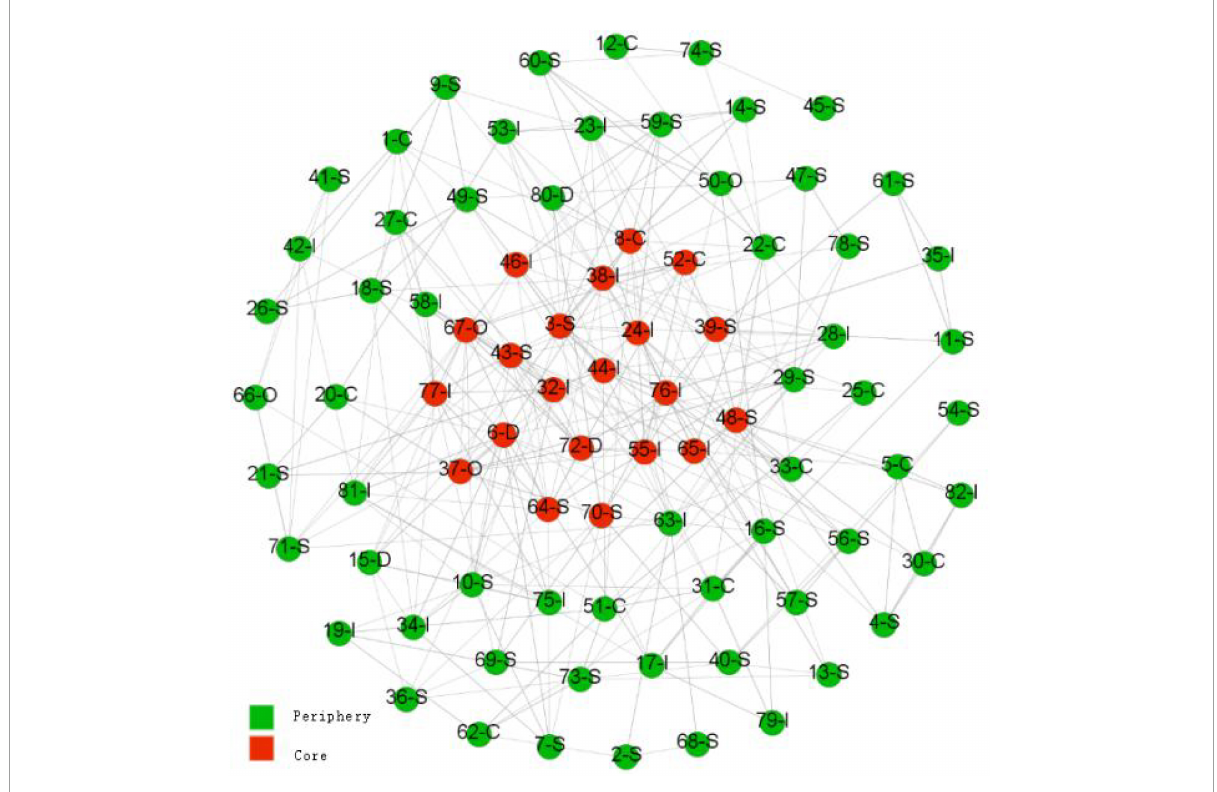
FIGURE3 Core-periphery analysis of friendship network (personality traits). Numbers represent the number of nodes (each individual). D, dominance traits; I, influence traits; S, steadiness traits; C, compliance traits; O, chameleon traits.